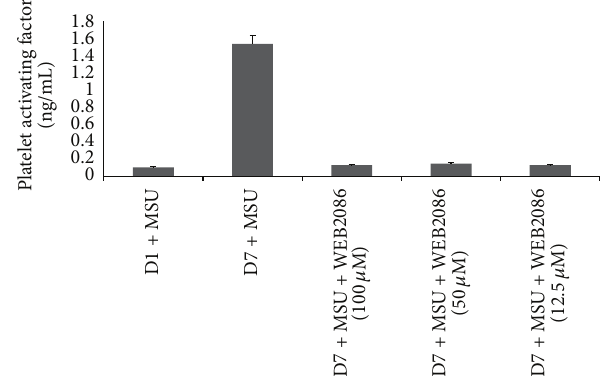
Figure 2: Platelet activating factor (PAF) production by D7 in vitro differentiated macrophages incubated with MSU crystals and with or without WEB2086 (WEB). Monocytes were cultured for 1 and 7 days and stimulated with MSU crystals and collected supernatants were analysed for PAF by ELISA. Results are mean and SEM of 4 experiments. D7 = supernatants from day 7 macrophages, D1 = supernatants from day 1 Monocytes, and WEB = WEB2086. Macrophages also secreted PAF when incubated with LPS ( 1.48 ± 0.10 mean ± SEM;ng/mL per 10 6 cells), data not